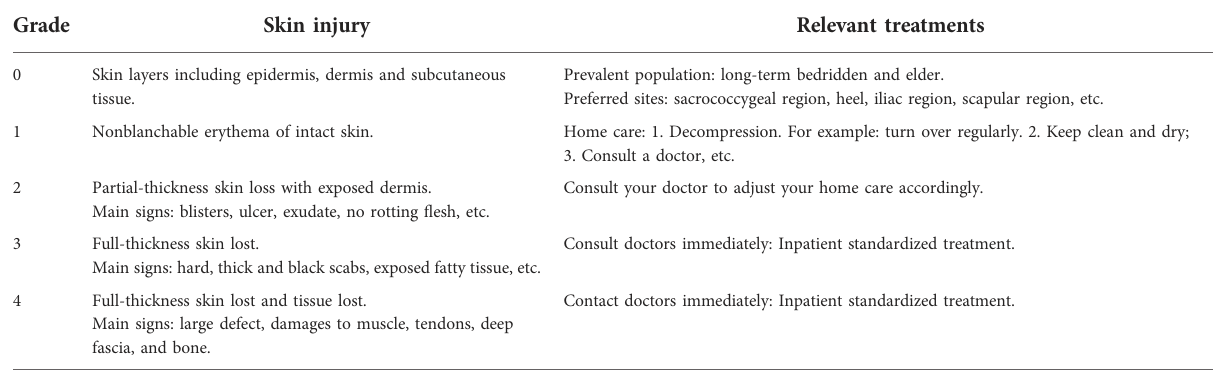
TABLE 1 The contents in three circles. Grade Skin injury Relevant treatments 0 Skin layers including epidermis, dermis and subcutaneous